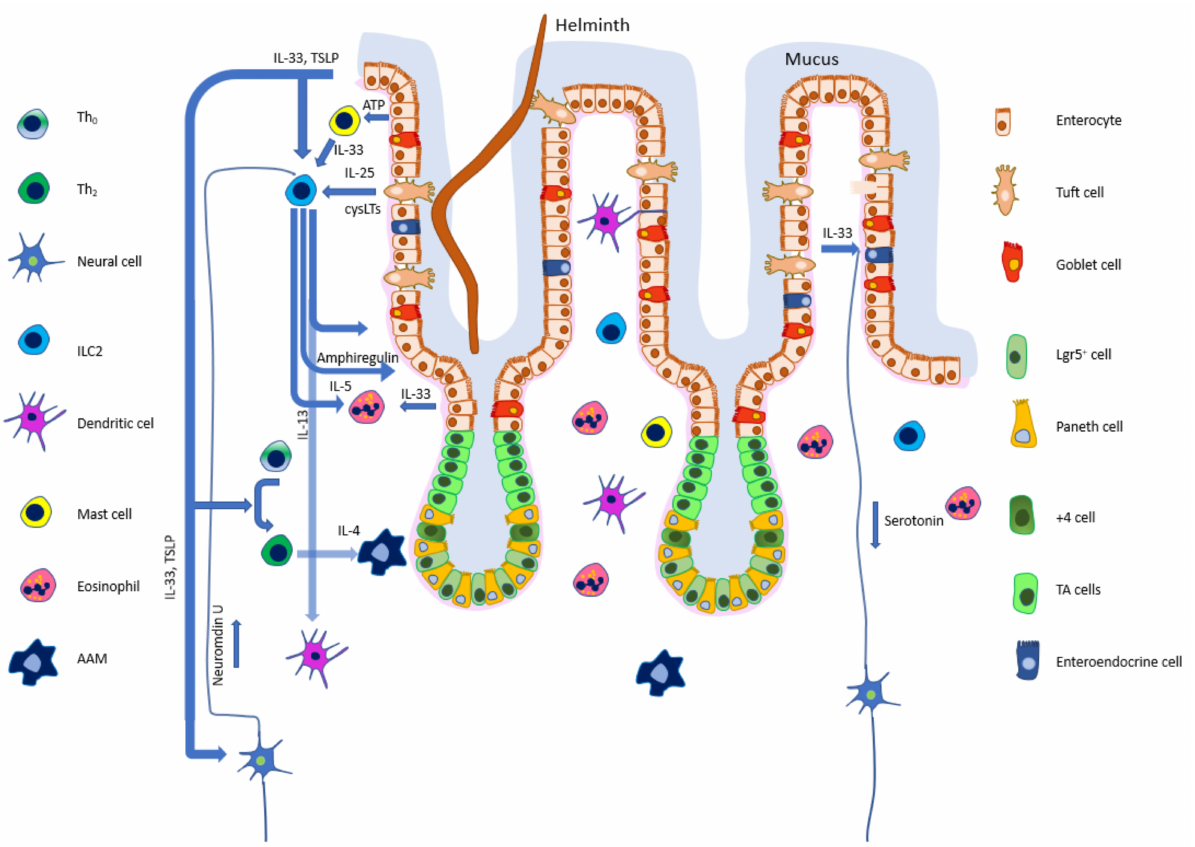
Figure 1. Helminth induced interactions between epithelial, neural, and immune cells. Upon infection tuft cells (TC) release IL-25 and other intestinal epithelial cells (IEC) secrete TSLP, IL-33, and ATP, signaling tissue damage. Group 2 innate lymphoid cells (ILC2) stimulated by alarmins release IL-4, IL-5, IL-9, and IL-13, inducing goblet cell secretion, alternatively activated macrophages (AAM), and eosinophilia. ILC2 also cooperate with the nervous system, and upon being stimulated by neuromedin U release amphiregulin which has tissue-protective properties. Enteroendocrine cells in response to IL-33 release serotonin which induces muscle contraction or epithelium